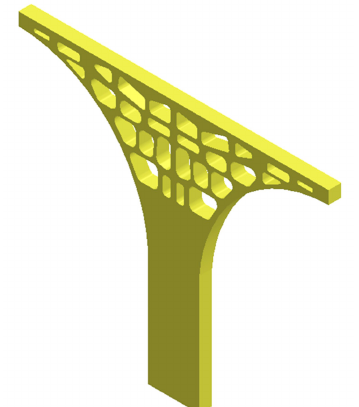
Figure 2. Three-dimensional computer-aided design (3D-CAD) model of the tree column structure.